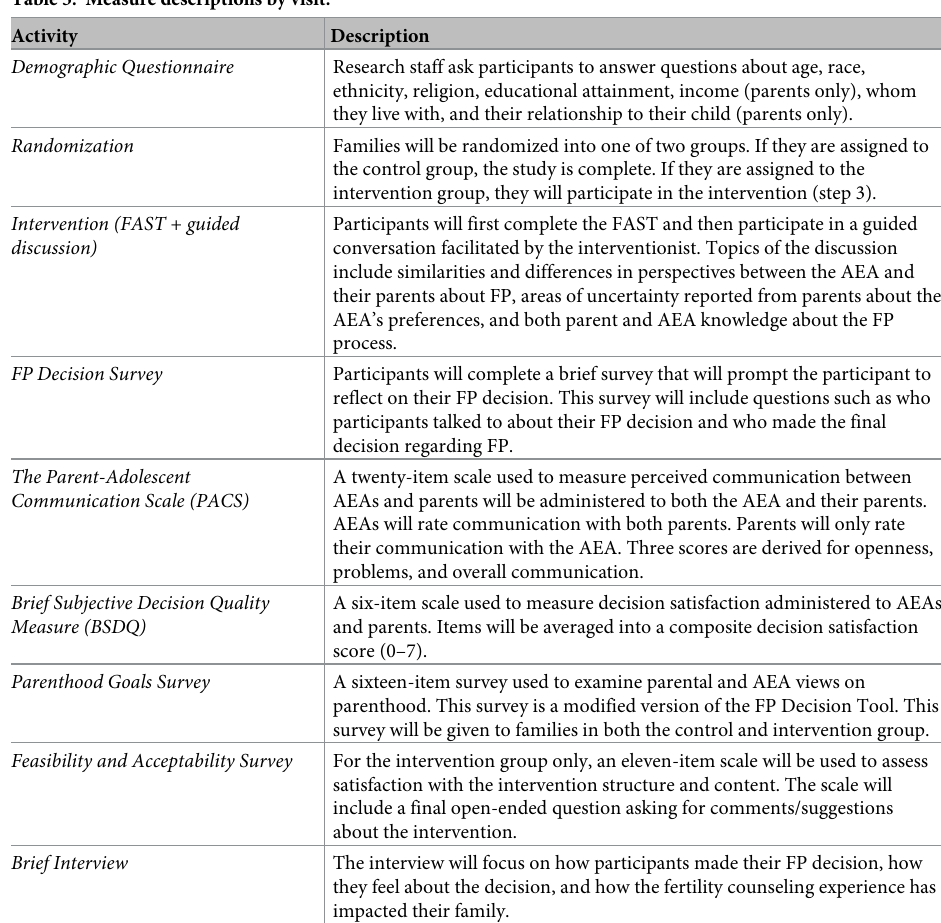
Table 3. Measure descriptions by